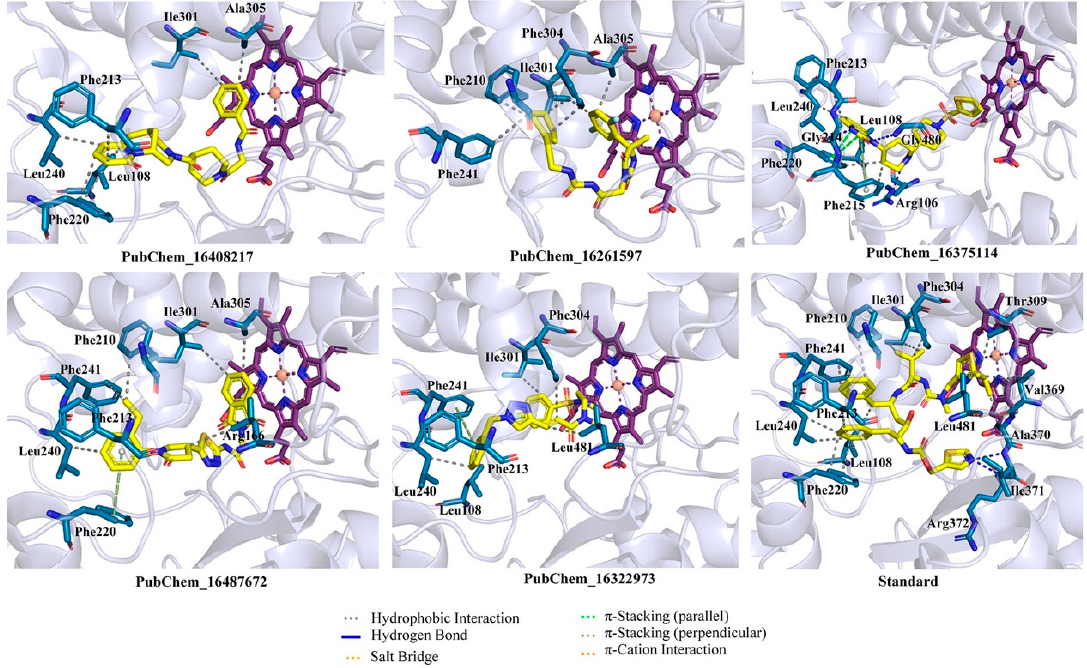
Figure 6. Binding interaction profile of final CYP3A5 molecules. A number of hydrogen and hydrophobic binding interactions are observed.